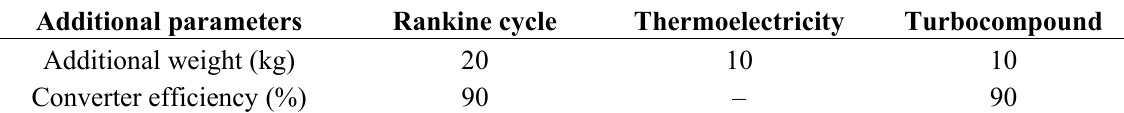
Table 1. Characteristics for the simulation of the different waste heat recovery technologies [15,27,39].